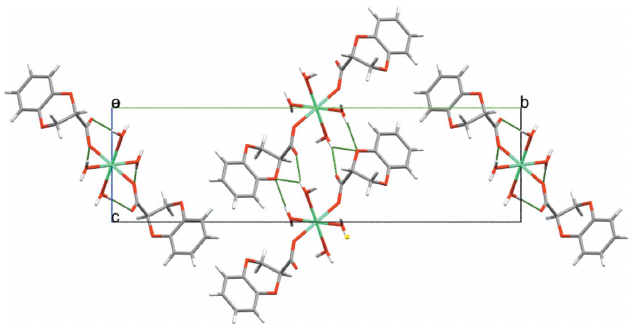
Figure 1 The molecular structure of the title compound with displacement ellipsoids drawn at the 50% probability level. Unlabeled atoms are generated by the symmetry operation 1 (cid:4) x , 1 (cid:4) y , 2 (cid:4) z .